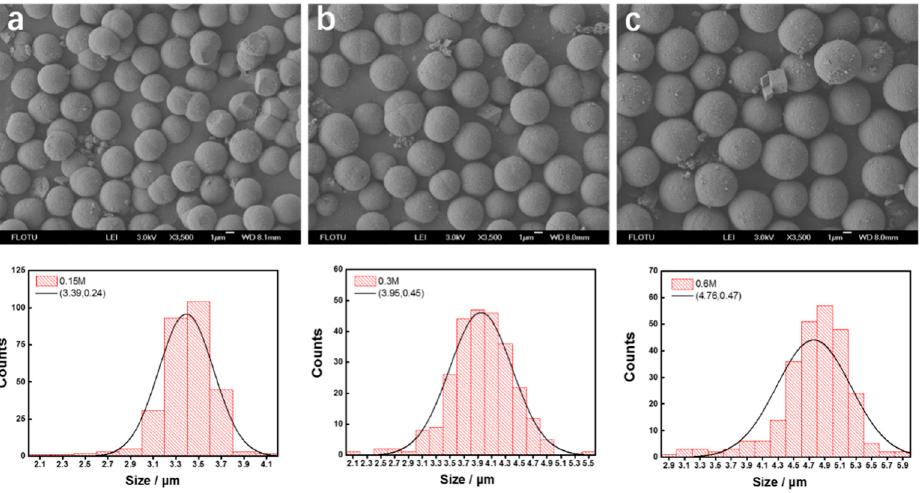
Figure 8. SEM images and size distributions of the products after hydrothermal treatment when using starting materials at different concentration ( C M ). ( a ) 0.15 mol·L − 1 ; ( b ) 0.3 mol·L − 1 ; ( c ) 0.6 mol·L − 1 . R M = 1:1:1 ( Ni:Co:Mn ) ; C (NH4 ) 2CO3 = 0.15 mol·L − 1 ; T h = 180 °C; and t h = 24 h.